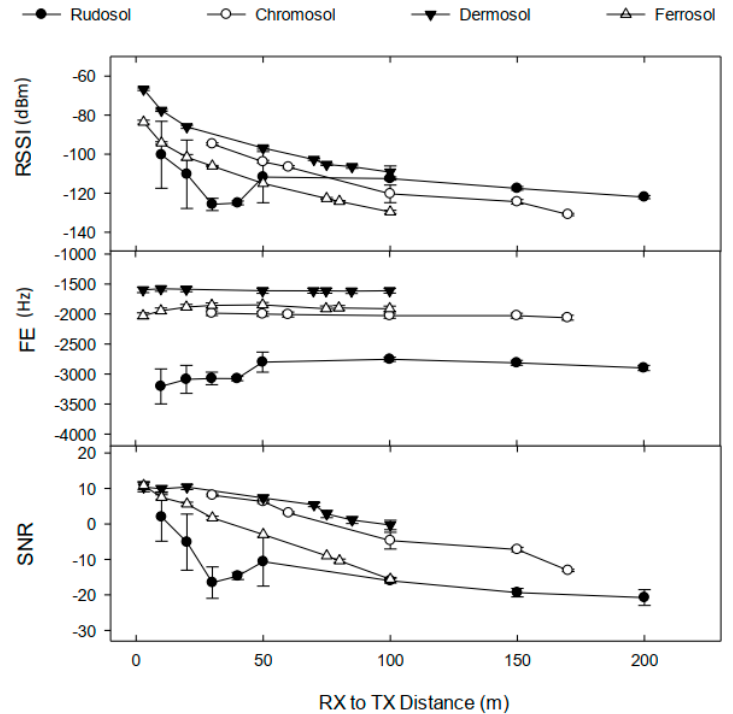
Figure 4. Effect of soil type on RSSI, FE, and SNR vs. RX to TX distance. Note: Values represent the average received RSSI, FE and SNR (+23 dBm TX power, TX buried at 15 cm depth, 0.2 kbps data rate, and 1/3 λ RX antenna). RSSI (dBm) refers to received signal strength index, FE (Hz) refers to frequency error, and SNR refers to signal-to-noise ratio. Error bars indicate ±1 standard deviation.